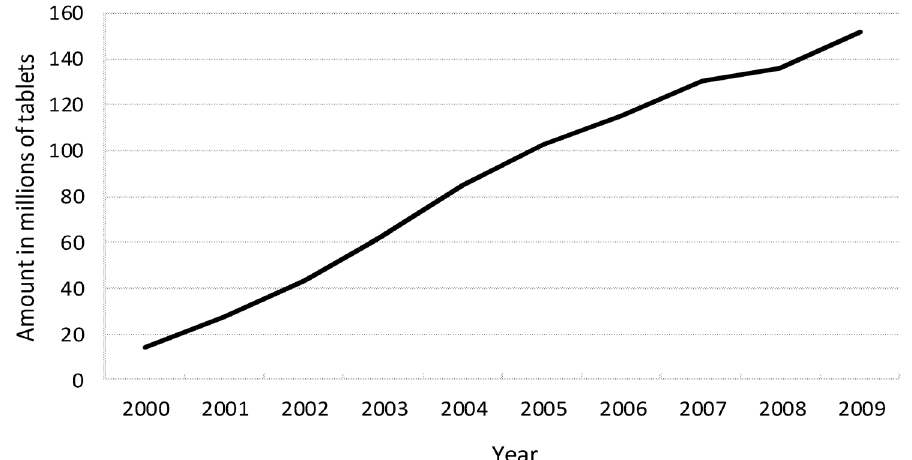
Fig 1. Estimated zolpidem usage from 2000 to 2009 in Taiwan. (Estimates were calculated by dividing the annual cost by the average price for a zolpidem tablet. Source: Bureau of National Health Insurance in